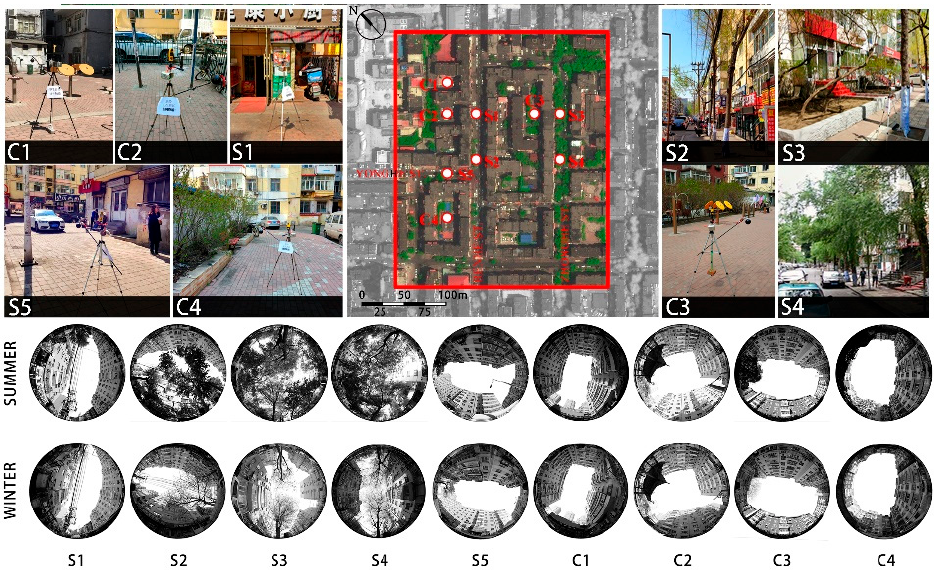
Figure 1. Locations of meteorological measurements and fisheye photos of each monitoring site in summer and winter.